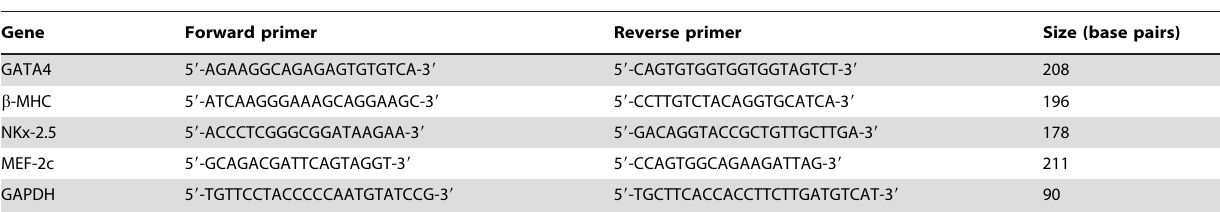
Table 1. Primers for real-time RT-PCR.